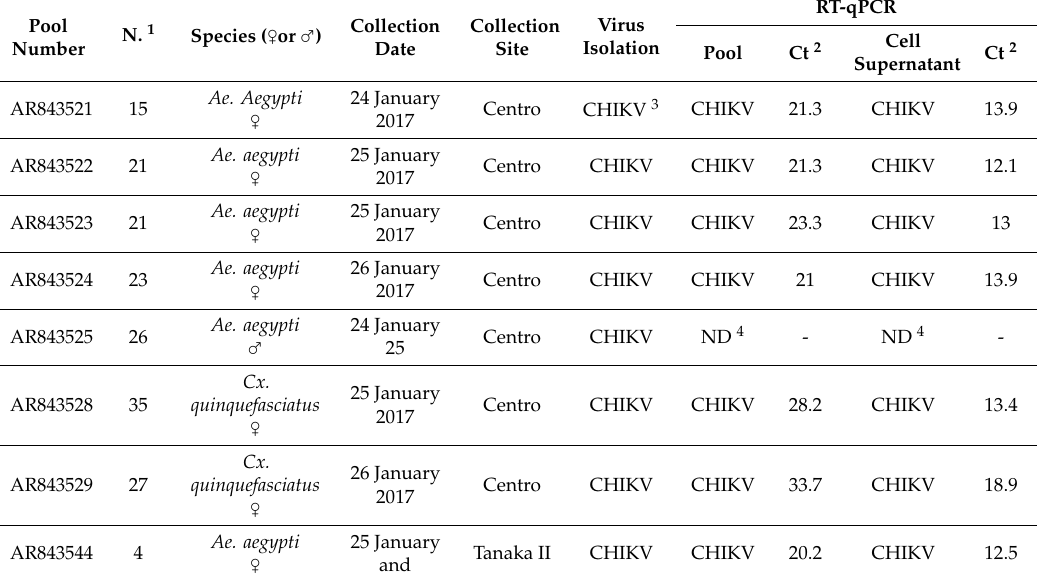
Table 2. Investigation of mosquito pools by virus isolation and RT-qPCR during the chikungunya outbreak in Xinguara, Par á ,